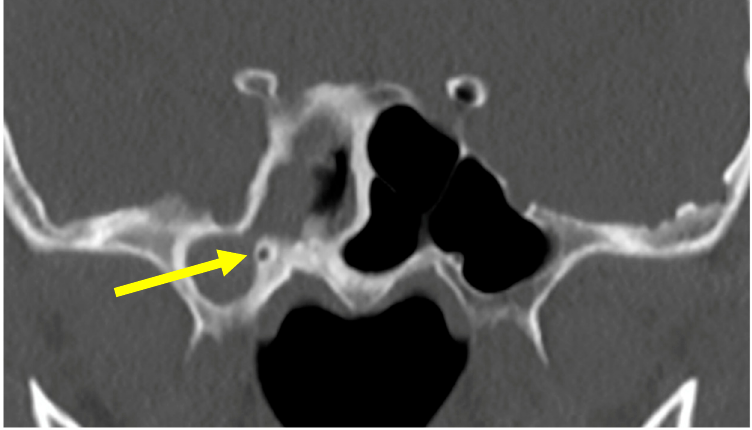
Figure 1. The sphenoid sinuses. The arrow indicates the narrow opening into the lateral recess.